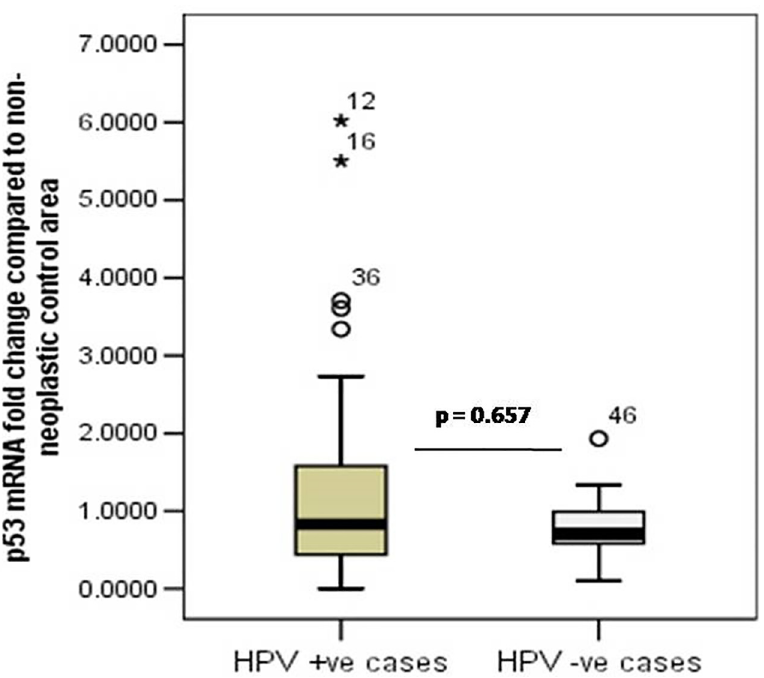
Fig 1. Box plot analysis showing the downregulation of p53 mRNA expression in HPV positive and HPV negative cervical cancer cases. https://doi.org/10.1371/journal.pone.0238500.g001 downregulation of p53 mRNA expression was not uniform in CaCx cases of different severity grades. The p53 mRNA expression was downregulated in lower severity stage (stage IIA and IIB) compared to higher stages of CaCx ( � stage III) (Fig 2A). The expression of p53 was